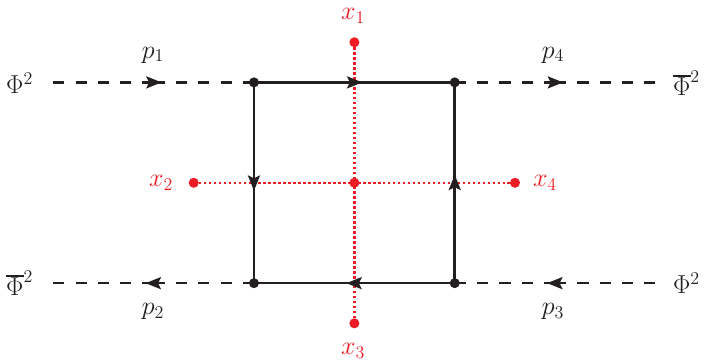
Figure 3: The scalar box diagram corresponding to the 4-point function (4.1) in the theory of a free complex scalar field. The solid lines are propagators of the field Φ , with arrows indicating the charge flow. The external, dashed lines correspond to the 2 composite operators Φ 2 and Φ . The dual graph in terms of the variables x is shown in red, with dotted